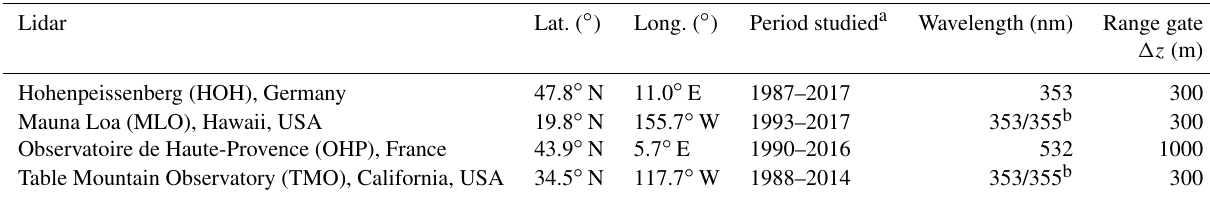
Table Mountain Observatory (TMO), California,